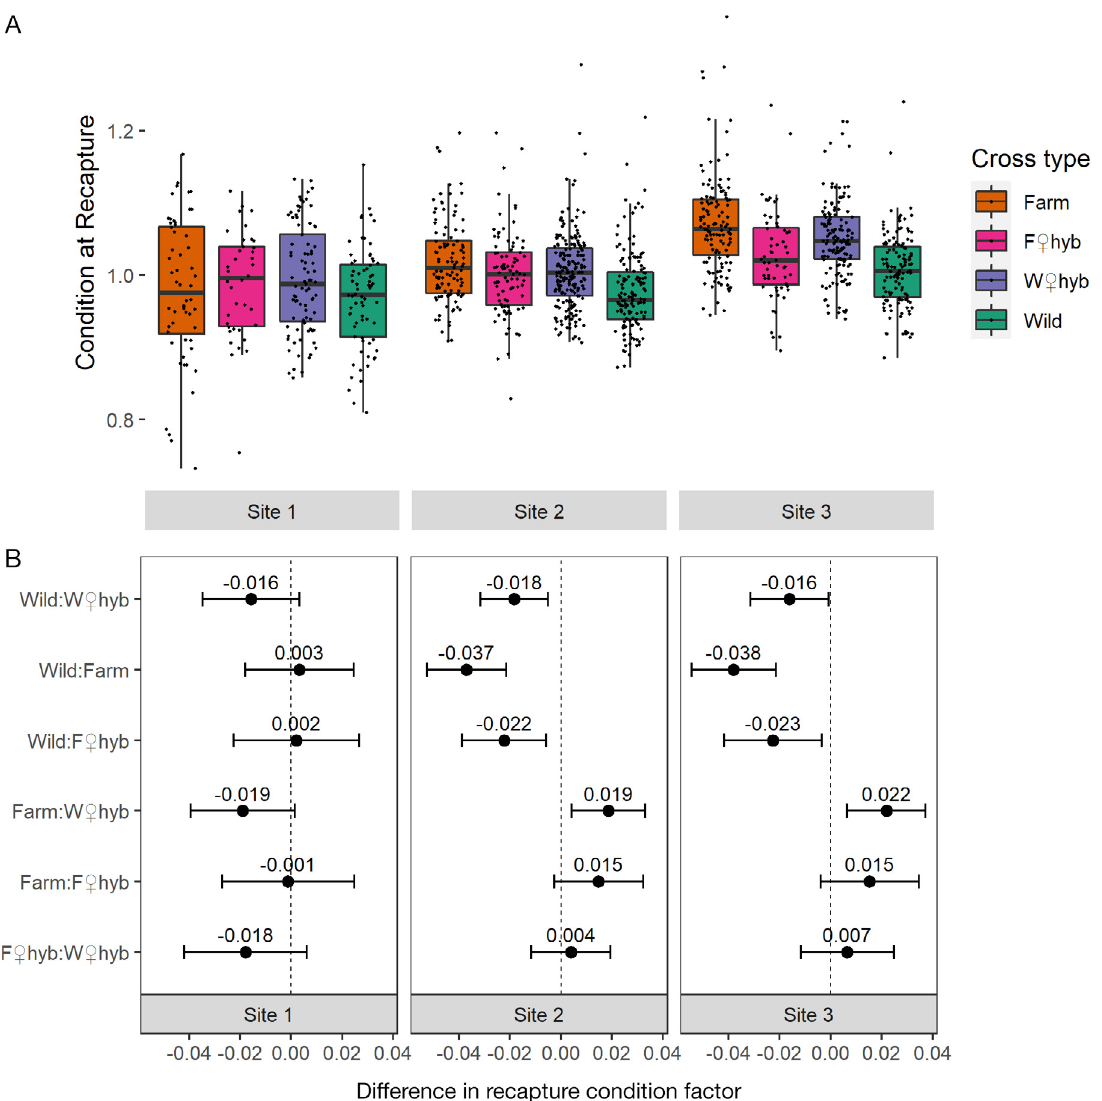
Fig. 7. Same as Fig. 5, but for (A) condition of each Atlantic salmon at recapture for each cross type by site pairing, and (B) pairwise differences in mean condition for each cross type by site at Site 3, with W f hyb having fewer parr marks than all 3 of the other crosses (differences all >1.7 marks; Fig. 8A, Table S7). In contrast, differences for all other pairs were <1.2 marks, with their 2*SE marks spanning zero difference in number of marks. There was strong evidence for an effect of standard length and site on mean mark length and width (Table 2). The largest differences in mean mark length at the grand mean of standard length (44.7 mm; back-calculated from ln-transformed grand mean length output by emmeans function) were at Site 1 for F f hyb :W f hyb and farm: W f hyb (Fig. 8B). How- ever, difference in size of marks for all pairs was